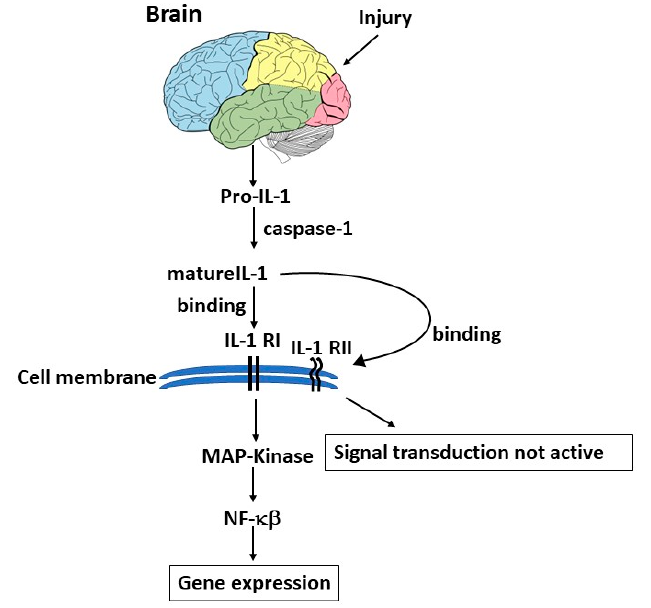
Figure 2. Brain injury causes the activation of pro-IL-1 which is cleaved by caspase-1, leading to mature IL-1 which binds its receptor on the cell membrane, resulting in NF- κ B activation and gene expression.